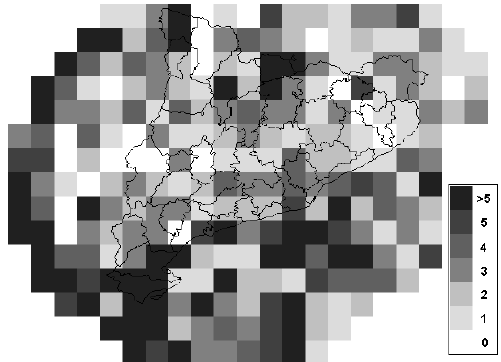
Fig. 4. Initial location of thunderstorms examined in this study. The grey scale indicates the number of times a thunderstorm has initiated in each grid cell of the region of